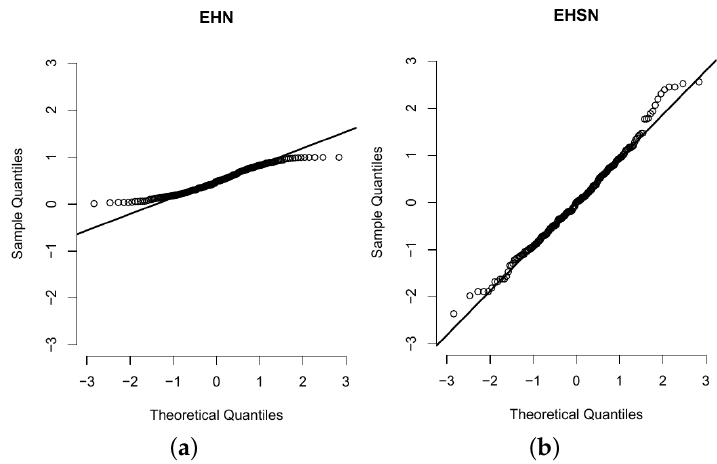
Figure 9. qqplots for volcano heights dataset: ( a ) EHN model, ( b ) EHSN model.